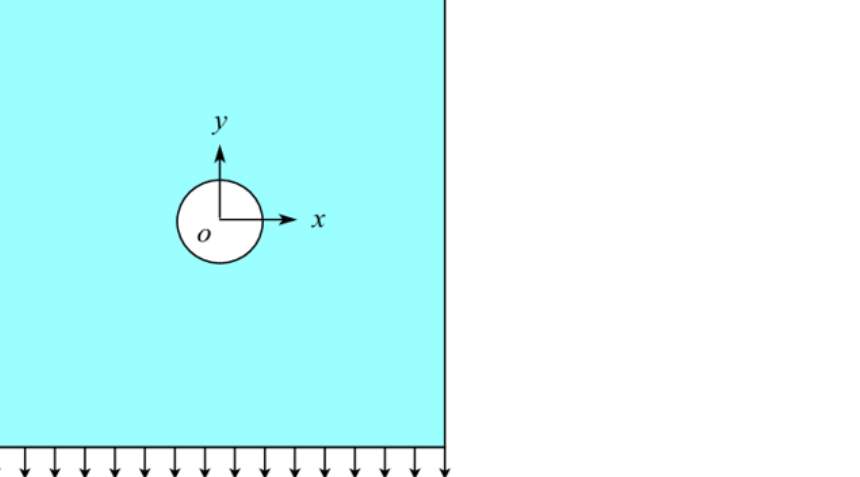
Figure 18. Squared plate with central circular hole subjected to uniform tension.